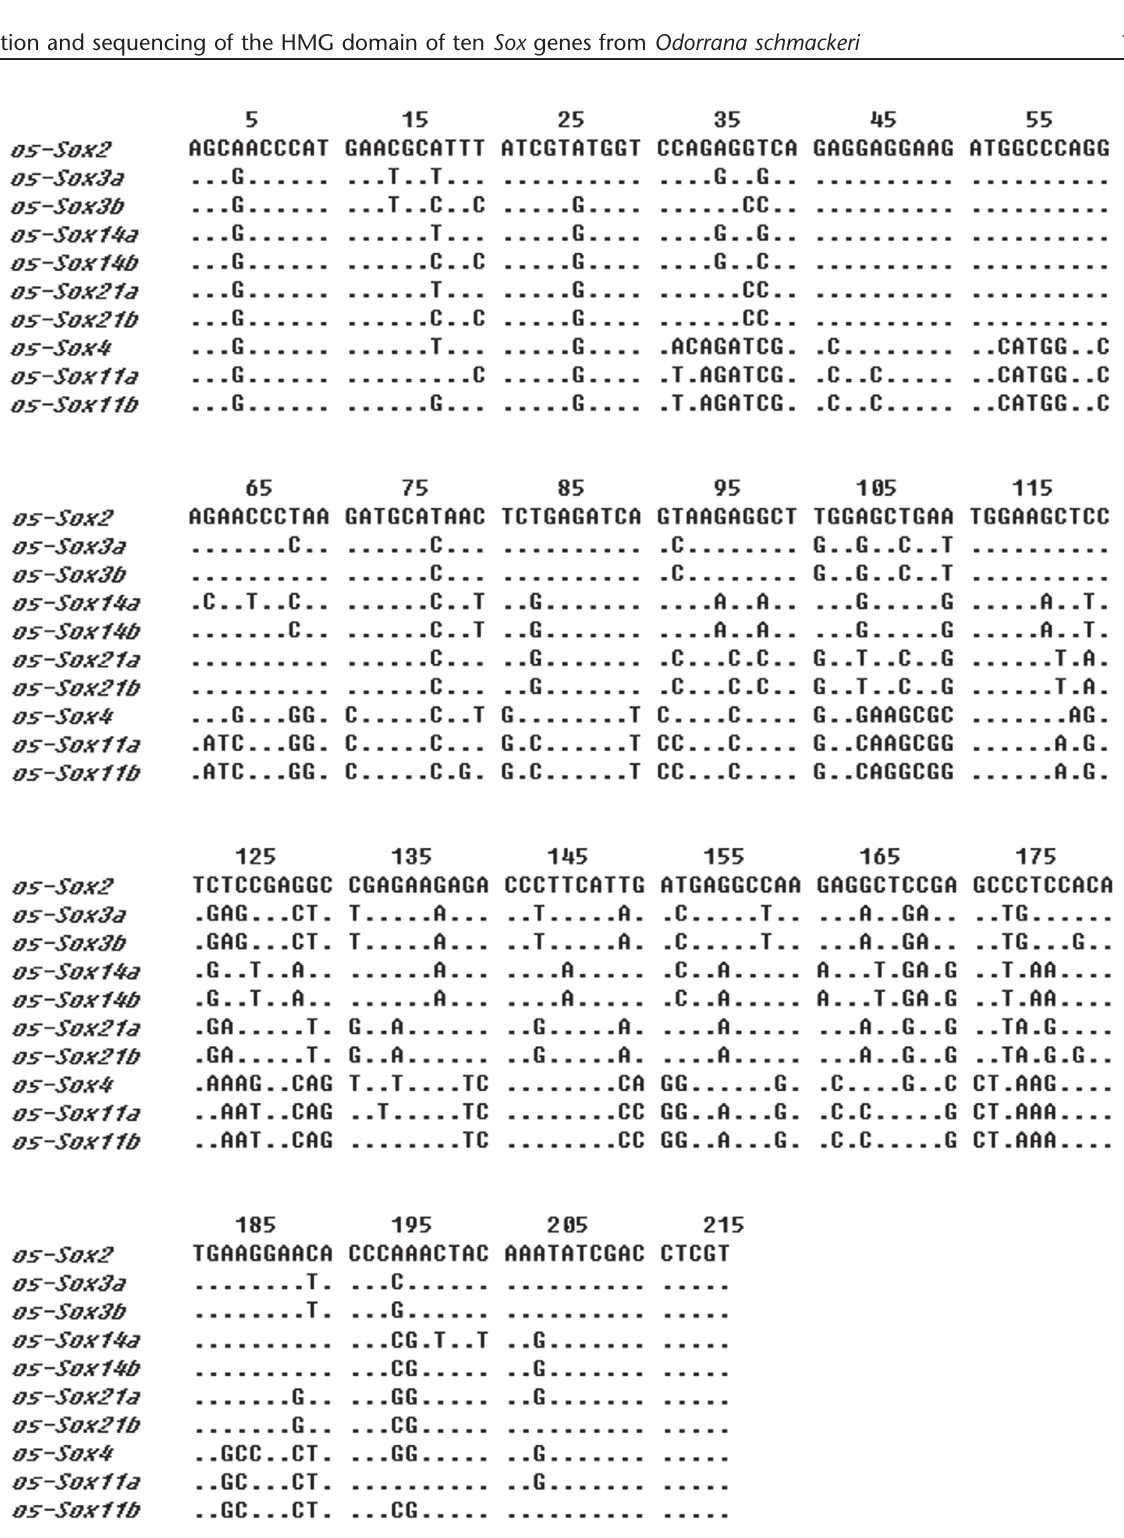
Figure 1. Alignment of nucleotide sequences of the HMG domain of os-Sox genes. Nucleotide residues identical to os-Sox2 are indicated by a